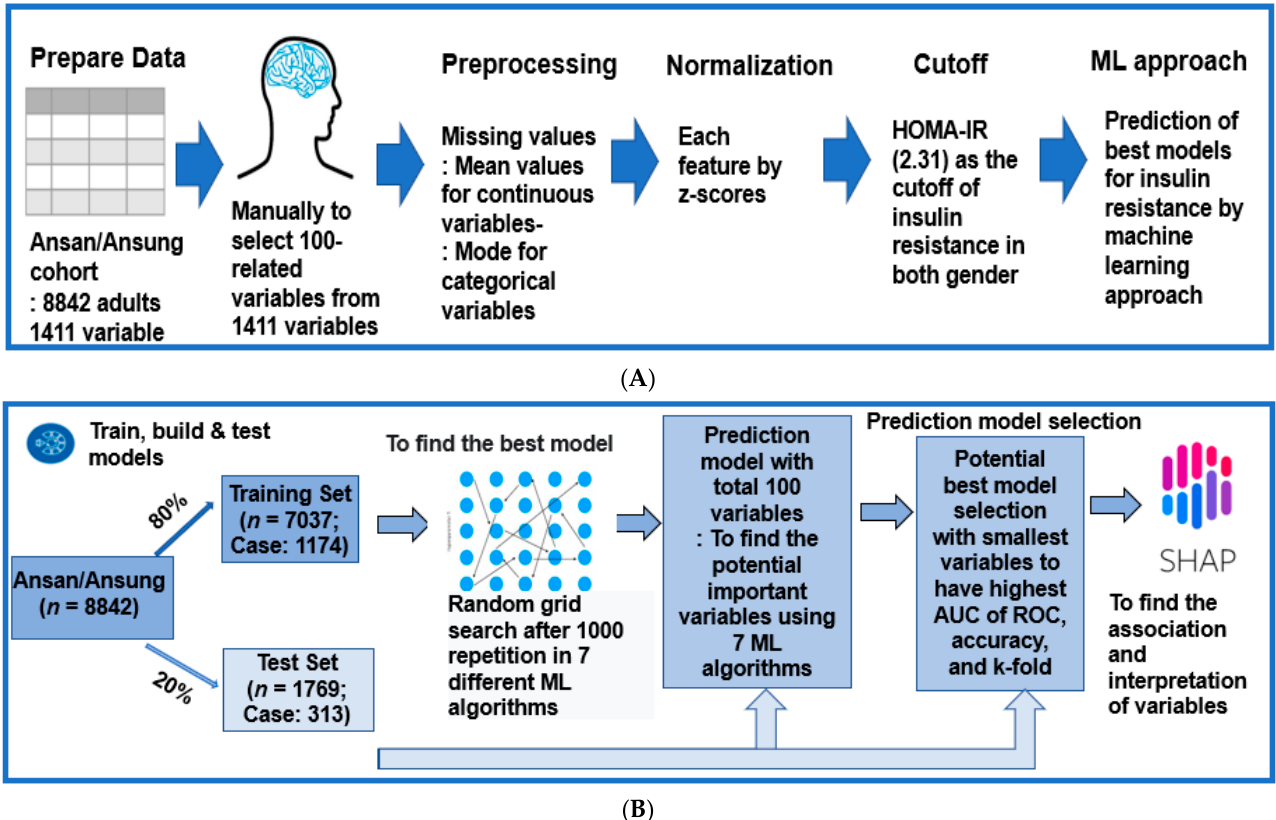
Figure 1. Analysis processing to generate a prediction model in the participants. ( A ) A total of 8842 adults participated, and 99 features were selected manually from 1411 in the Ansan/Ansung cohort to predict the insulin resistance model using the seven machine learning (ML) approach. Missing data were filled with the mean values for continuous variables and the mode values for the categorical variables. Data were normalized using the z-score. HOMA-IR was used as an indirect insulin resistance index, and 2.31 was used as the cutoff for participants of both genders. The prediction models for insulin resistance were generated using seven ML algorithms. ( B ) The Ansan/Ansung cohort participants were randomly divided into a training set of 80% and a test set of 20% participants. The best model was selected with a random grid search after 1000 repetitions in seven different ML algorithms, including linear regression, support vector machines (SVM), XGBoost (XGB), decision tree, random forest, K-nearest neighbor (KNN), and artificial neural network (ANN). The best prediction model was selected using the AUC of the ROC. The accuracy and k-fold cross-validation of the predicted models were assessed in the test set.